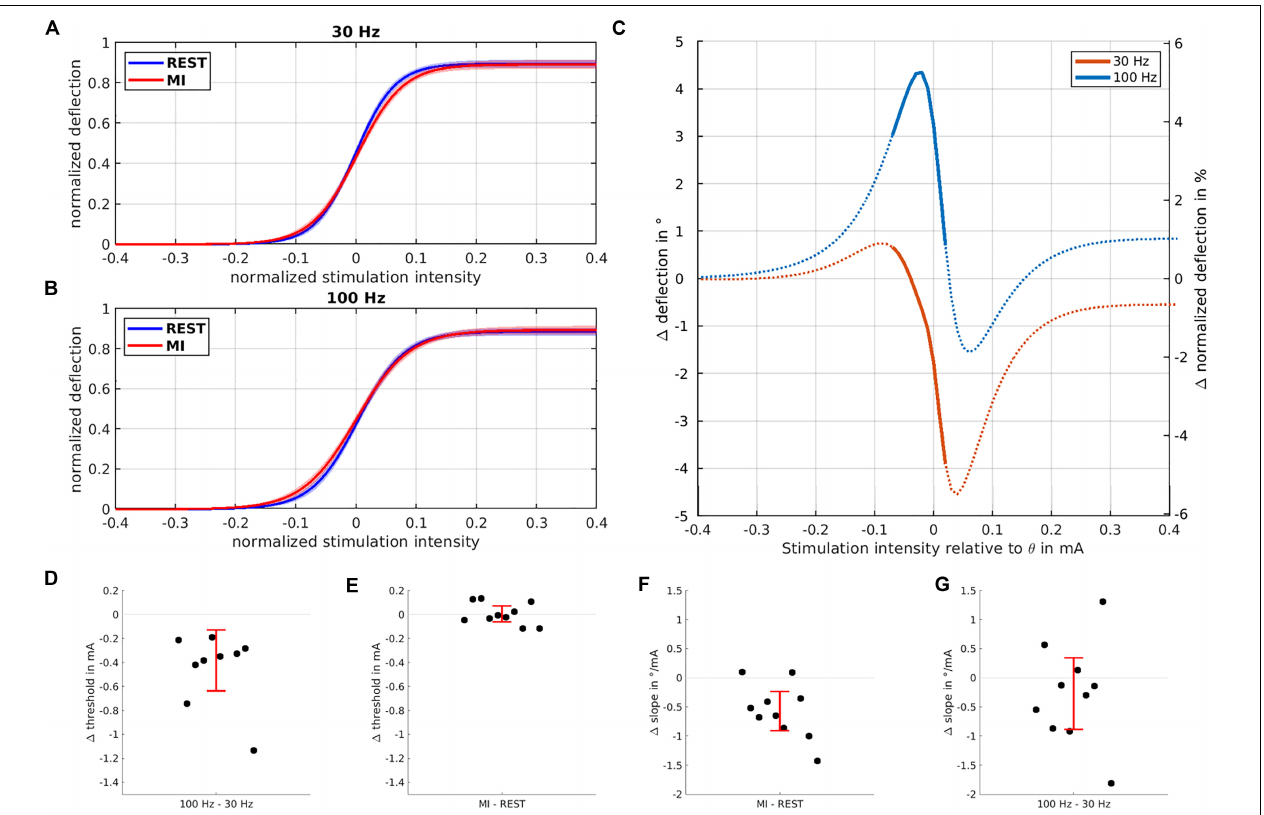
FIGURE 2 | Influence of stimulation intensity and motor imagery on curve parameters. The normalized input-output curves based on the sigmoidal model fit and averaged across all subjects are shown for 30 Hz (A) and 100 Hz (B) highlighting the kinematic deflection when NMES was applied during REST (blue trace) vs. MI (red trace). (C) Modulation of the input-output curves induced by MI for 30 Hz (blue trace) and 100 Hz (orange trace) stimulation; most pronounced wrist deflection occurs at subthreshold intensities for 100 Hz stimulation. Significant differences between the two frequencies are marked by thick lines. The threshold is significantly reduced (D) when stimulation is performed at 100 vs. 30 Hz, but not for MI vs. REST (E) . The slope of the IOC (F) is significantly reduced when stimulation is performed during MI vs. REST, but not for 100 vs. 30 Hz (G) . In all four lower plots (D–G) , each dot indicates a single subject, with the red error bars showing the 95% confidence interval of the mean